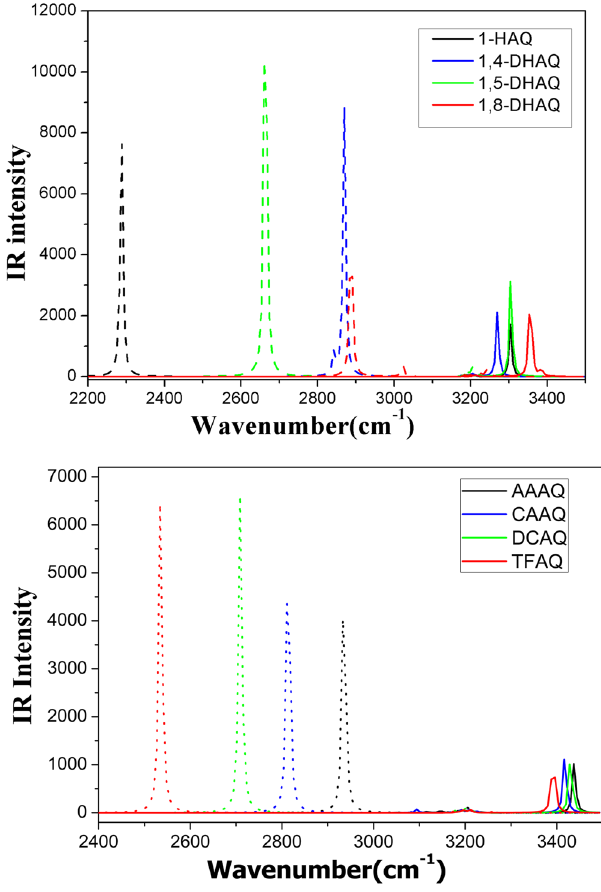
Figure 5. The calculated IR spectra of eight compounds in the spectral region of both O–H or N-H stretching modes in the S 0 and S 1 states (the solid line and dash line show the corresponding vibrational modes in S 0 and S 1 states, respectively).